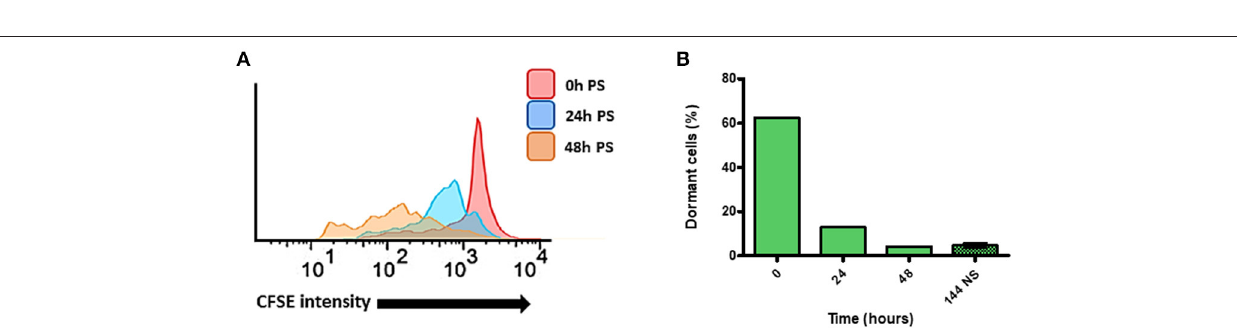
FIGURE 1 | Dormancy in epimastigote forms of T. cruzi wild type strains. (A) Cellular growth curves from four different strains (CL Brener, Bug, Dm28c, and Y). At 0h, 1 × 10 7 cells were treated with CFSE and samples were counted every 24h for 144h. (B) Flow cytometry histograms of epimastigote cultures from each strain from 24 to 144h. CFSE intensity was assessed every 24h until 144h, and arrested cells were considered those ones which exhibited similar CFSE intensity at 144h when compared to the level of half median of 24h. (C) Average of percentage of dormant cells in CL Brener, Bug, Y, and Dm28c strains at 144h was detected in flow cytometry histograms. Representative results of three experiments. Asterisks indicate statistically significant differences among groups ( P -value < 0.05).